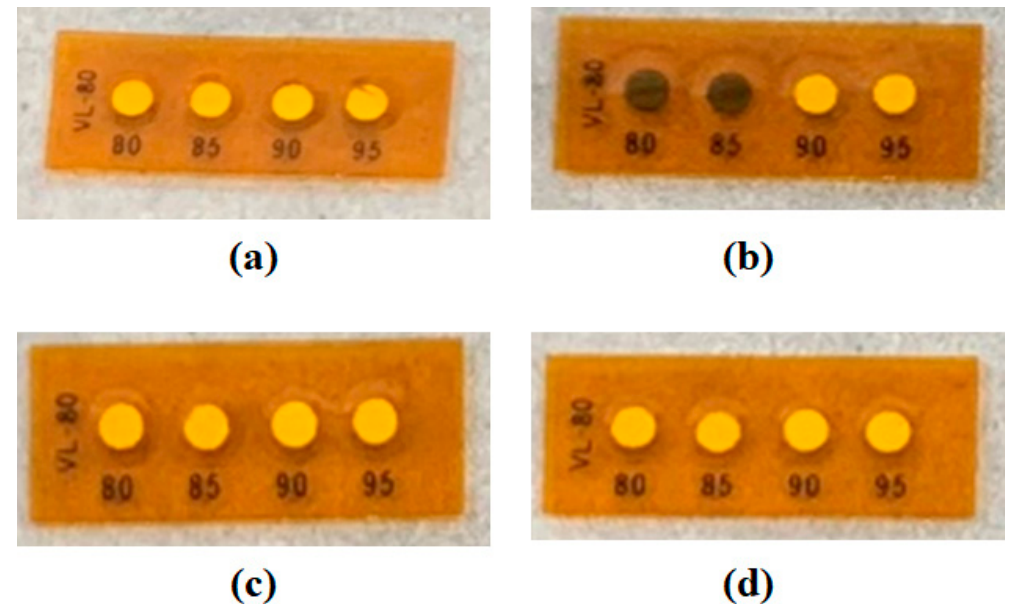
Figure 8. Color changes of the thermo label tape before and after sputtering. ( a ) Before sputtering, ( b ) After sputtering in DC magnetron, ( c ) After sputtering in OFTS, and ( d ) After sputtering in CFTS.